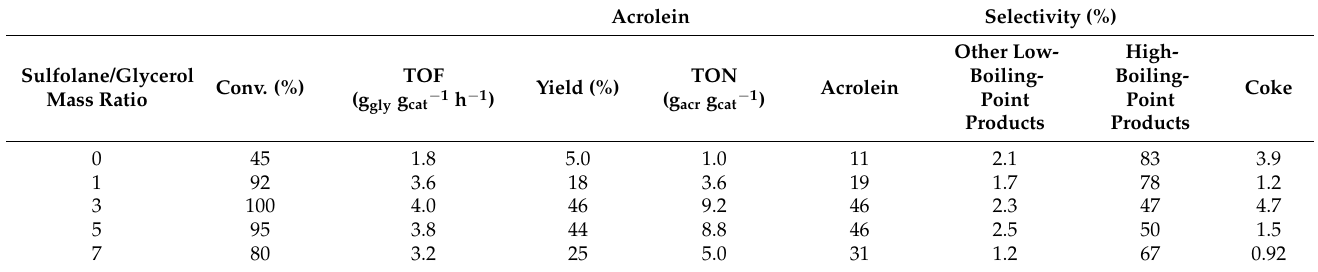
Table 4. Effect of sulfolane/glycerol ratio on liquid-phase dehydration of glycerol over ZSM-5_280 a . Acrolein Selectivity